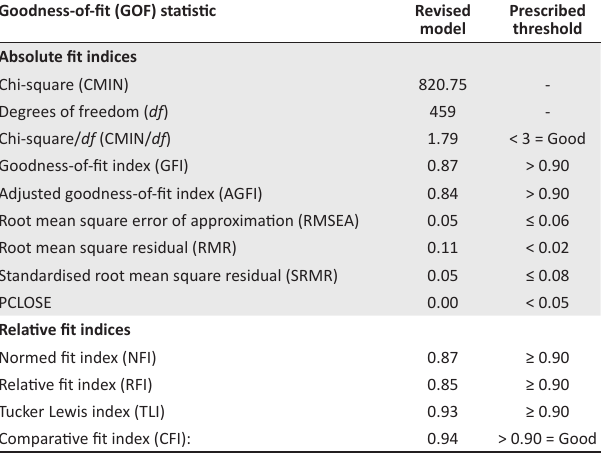
TABLE 2: Model fit: Revised model. Goodness-of-fit (GOF) statistic